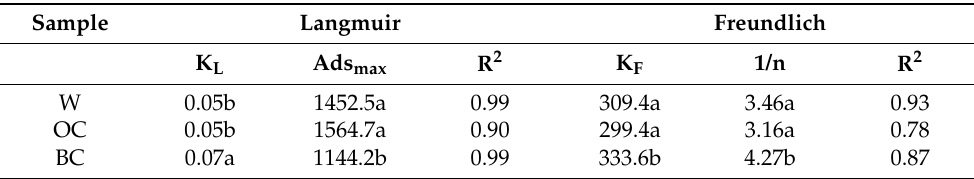
Table 2. Goodness of fit and parameters of the Langmuir and Freundlich equations observed for P adsorption in mining soil without organic amendments (W), with biochar (BC), and with organic compost (OC).